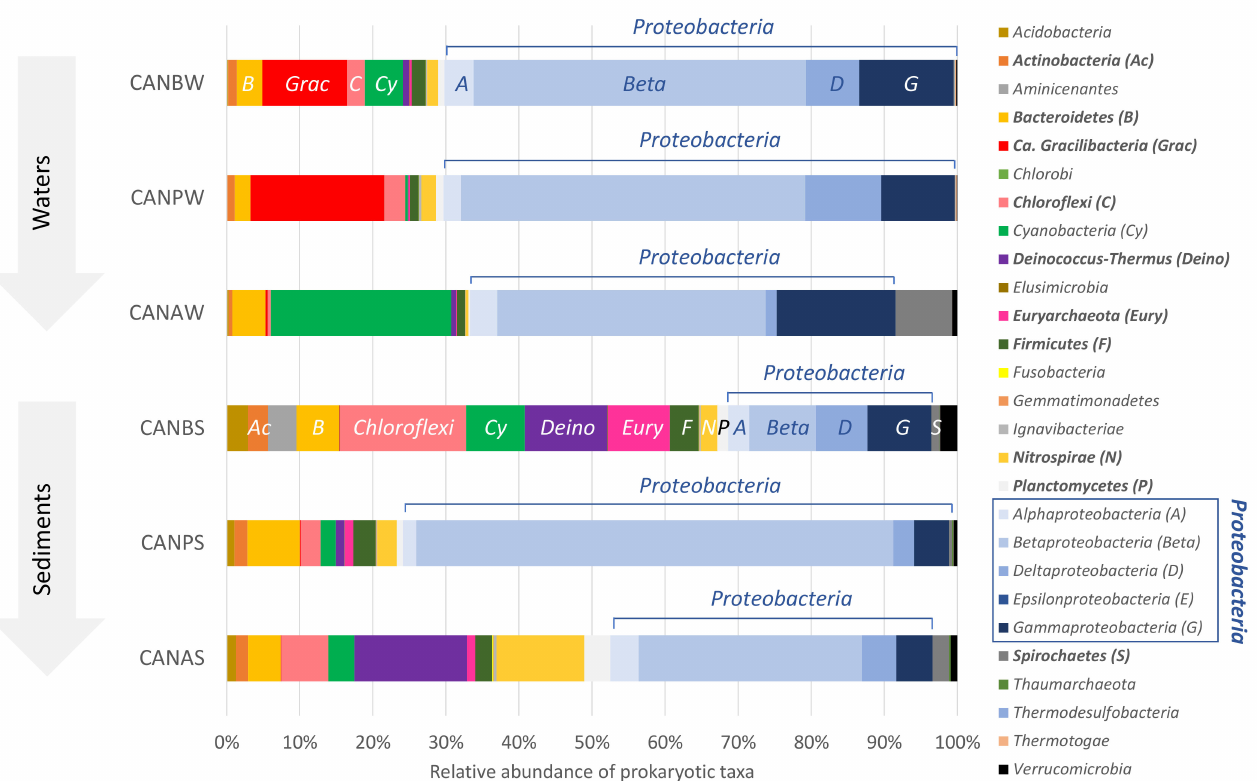
Figure 2. Distribution of the prokaryotic taxa in the waters and sediment samples along the water outflow of La Crouen spring (New Caledonia). Dominant phyla (>1% in average) are indicated in bold in the right-hand legend. Proteobacterial classes are distinguished by different blue colors. Sections of the bar chart of CANBW and CANBS samples are labeled with the corresponding taxa abbreviation as defined in brackets in the legend. CANB is the source bathtub, CANP is the outlet of a pipe below the source and CANA is the small pool below CANP before its entry into the river. W and S mean Water and Sediment, respectively. Values are averages of duplicate